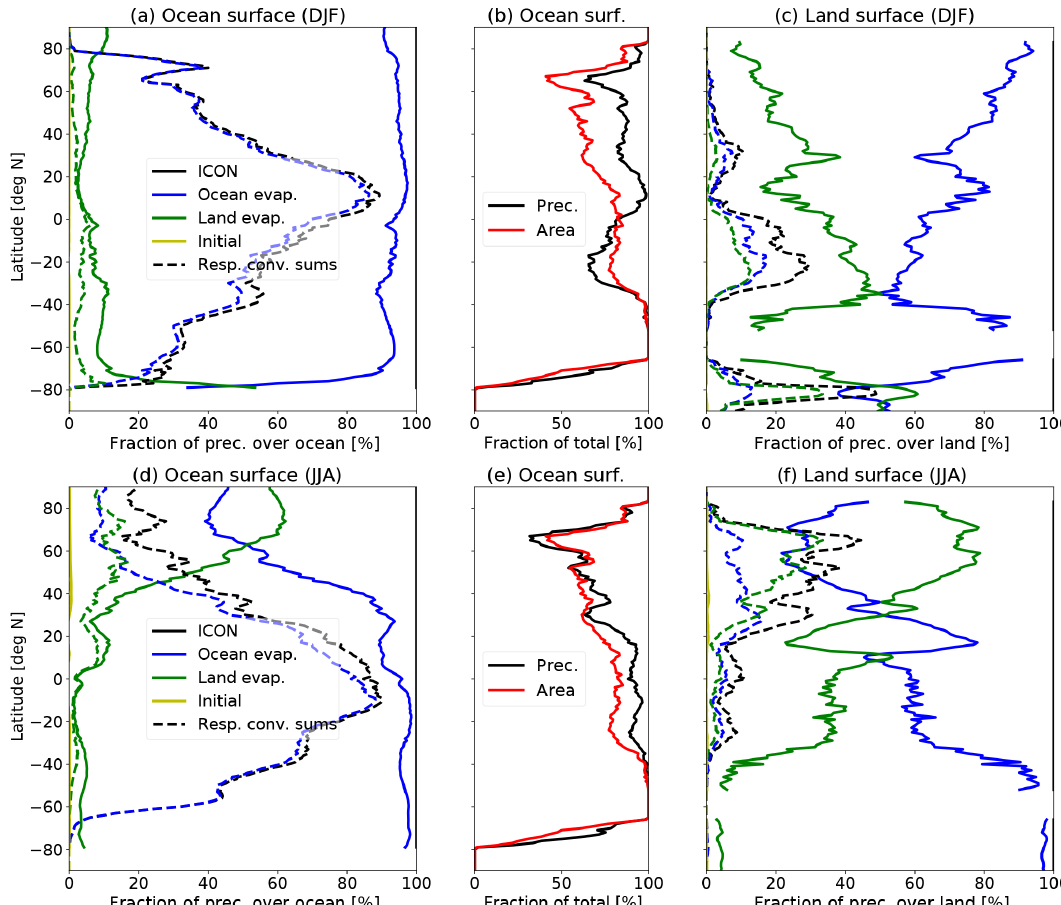
Figure 1. Fractional contributions of P ICON , P init , P ocn and P lnd to zonal sums of total precipitation for Northern Hemisphere winter (DJF, a–c ) and summer (JJA, d–f ) as a function of latitude. Outer panels show sums over the ocean and land grid points, respectively. Here, dashed lines indicate the contribution of convective precipitation for each source of atmospheric water. Center panels display the fraction of precipitation over the ocean relative to total precipitation (over land plus ocean) and the fraction of the area covered by